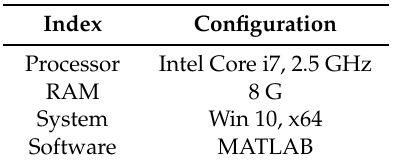
Table 2. Comparison of the estimation results produced by different algorithms.